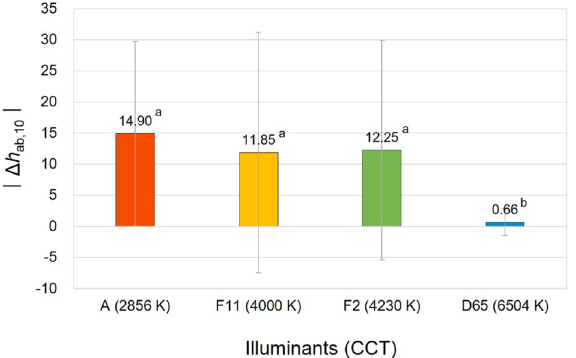
Figure 9. Effect of the correlated color temperature (CCT) of illuminants on the hue appearance change, (cid:31) (cid:31) (cid:31) (cid:31) h ab ,10 (cid:31) , of samples. (Δ h ab,10 = h A under the illuminant—spectrophotometrically measured h ab,10